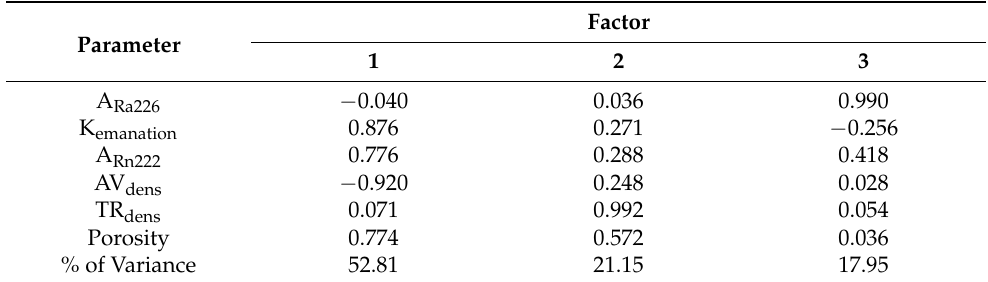
Table 5. Factor loadings matrix for dataset on the studied parameters of radon emanation.